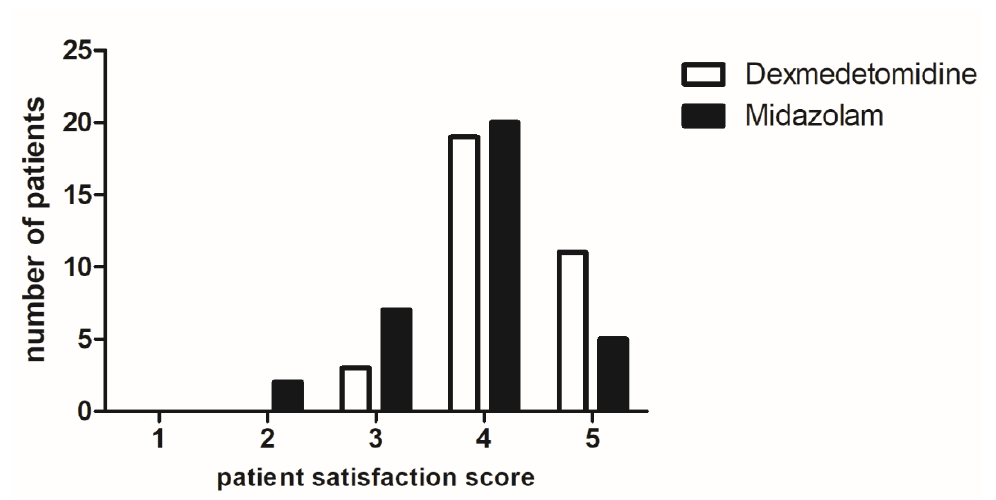
Figure 2. Patient satisfaction score.